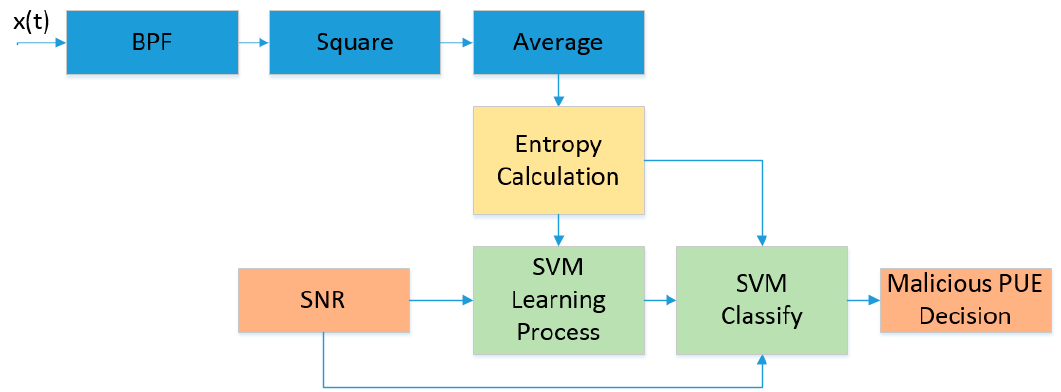
Figure 2. Proposed support vector machine (SVM) learning and classification process.